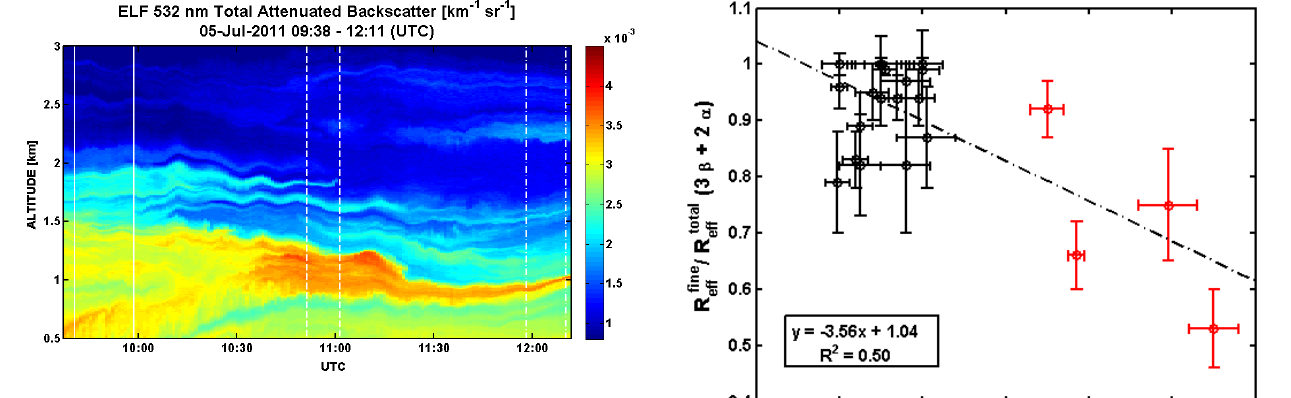
Figure 7. Total attenuated backscatter coefficient cross section ob- tained with elastic lidar (ELF) at 532nm at UMBC on 5 July. Long- range transport of smoke from fires occurring in the southeastern portion of the US was observed. White lines highlight the case stud- ies considered (see Table 1).